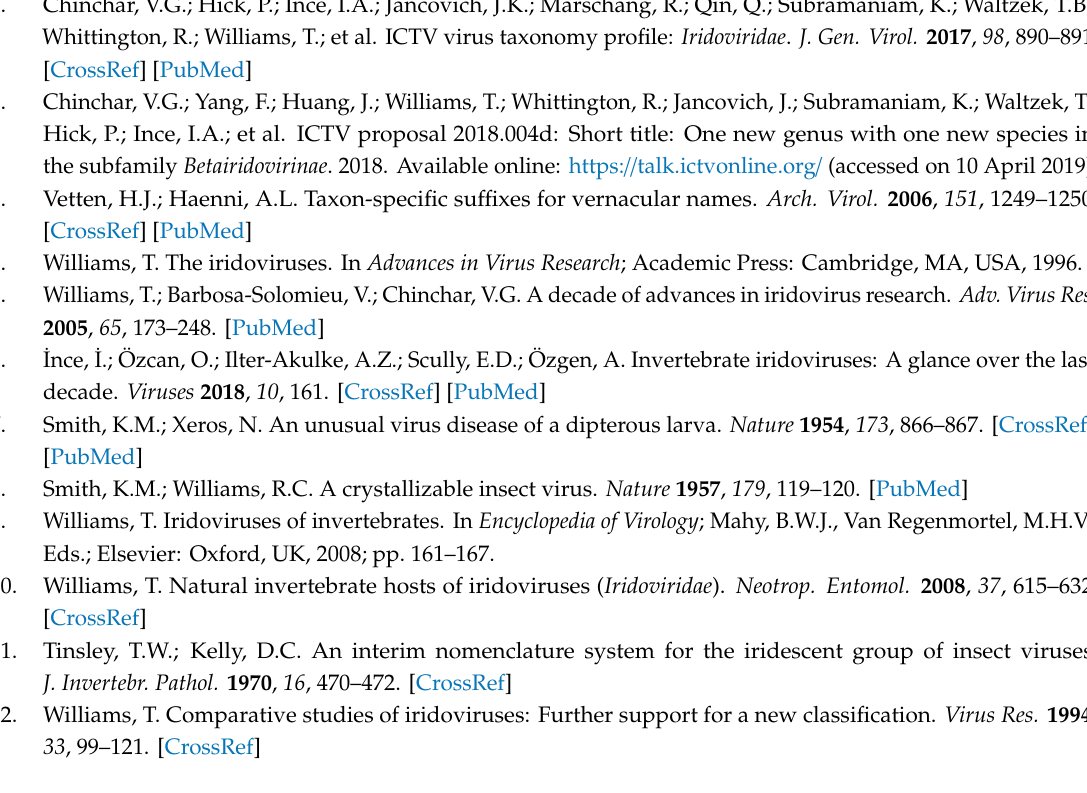
Figure S1: Phylogenetic tree based on the complete MCP gene data, Figure S2: SimPlot analysis of the sillucin gene homolog with its flanking regions; Figure S3: Phylogenetic tree reconstruction of Iridoviridae based on 25 core genes; Figure S4: Detailed results of the cricket bioassay; Figure S5: Detailed results of the bearded dragon infection study; Table S1: Animals of the bearded dragon infection study; Table S2: Primers used for PCRs and Sanger sequencing; Table S3: IIV detection in diagnostic samples, 2009-2018, Table S4: Sequence identity values (%) between Liz-CrIV and